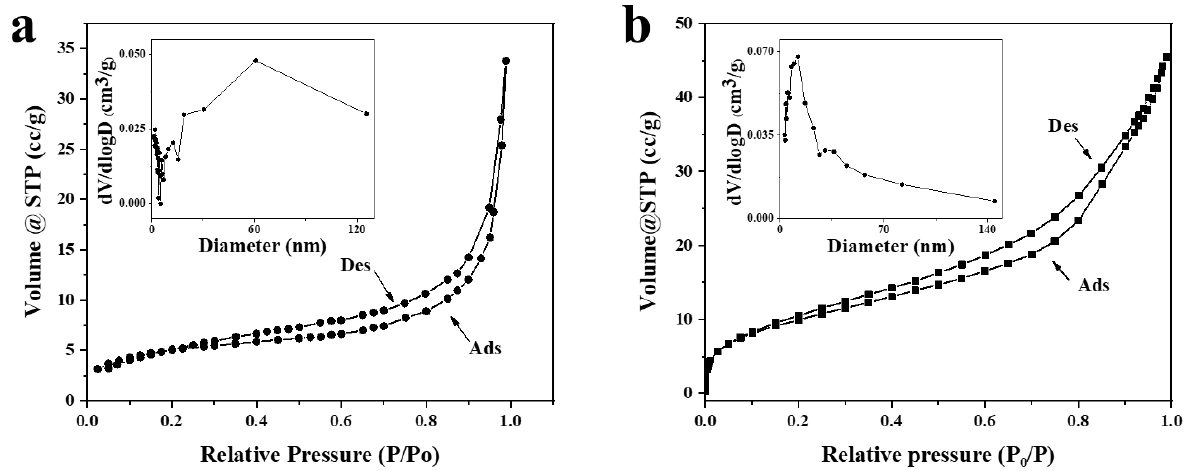
Figure 2. N 2 Adsorption and desorption isotherms, as well as size analysis of PDA nanoparticles ( a ) and MPDA nanoparticles ( b ). The abbreviations Ads and Des in the figures refer to adsorption and desorption, respectively.